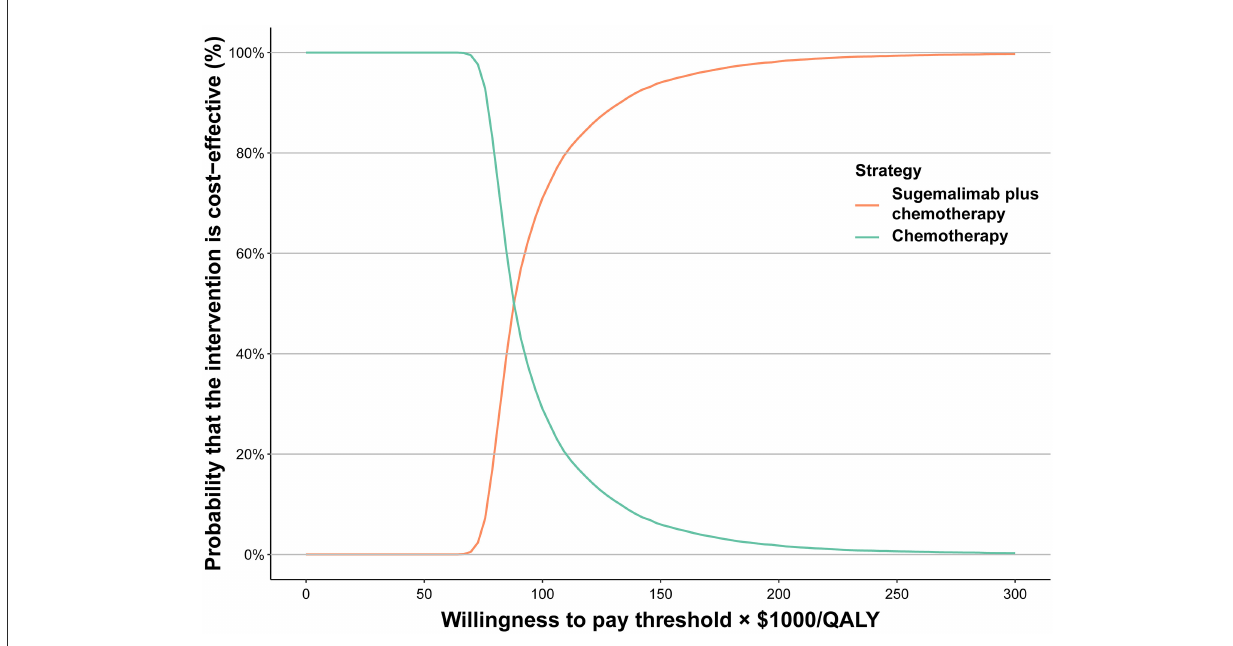
FIGURE1 Acceptability curves of cost-effectiveness. QALY, quality-adjusted life-year.